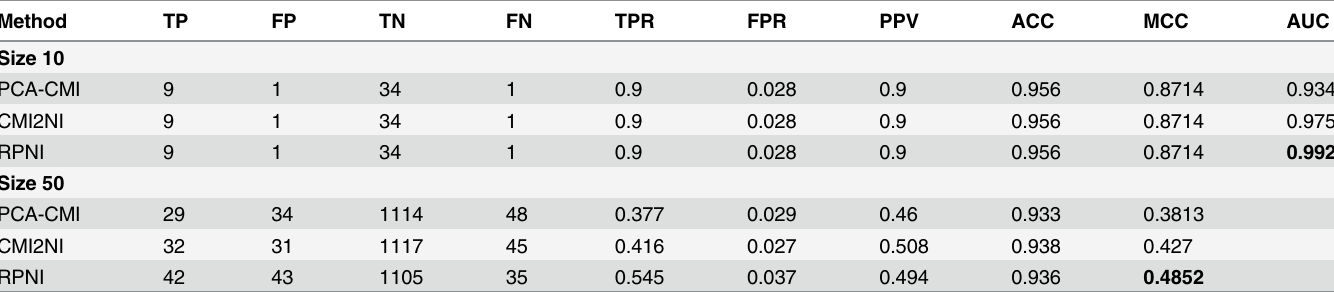
Table 1. Comparison of different methods using networks with sizes 10, 50. Method